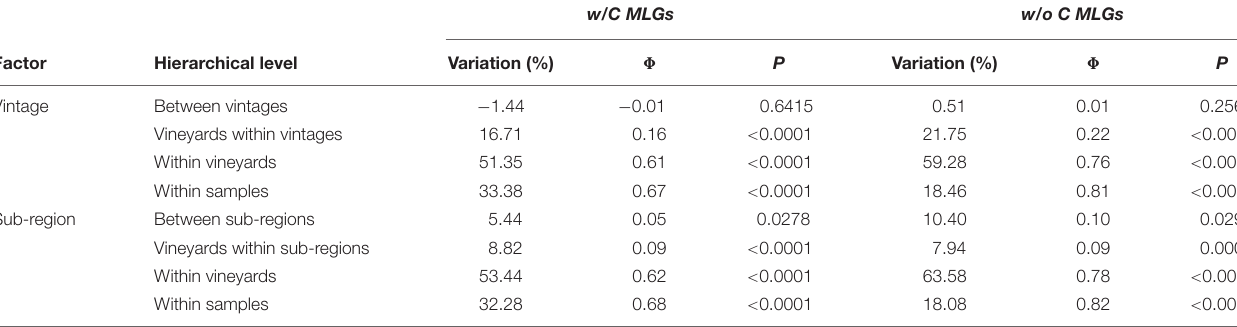
TABLE 1 | AMOVA of S. cerevisiae MLGs isolated in this study by vintage and sub-region, with and without commercial MLGs. w/C MLGs w/o C